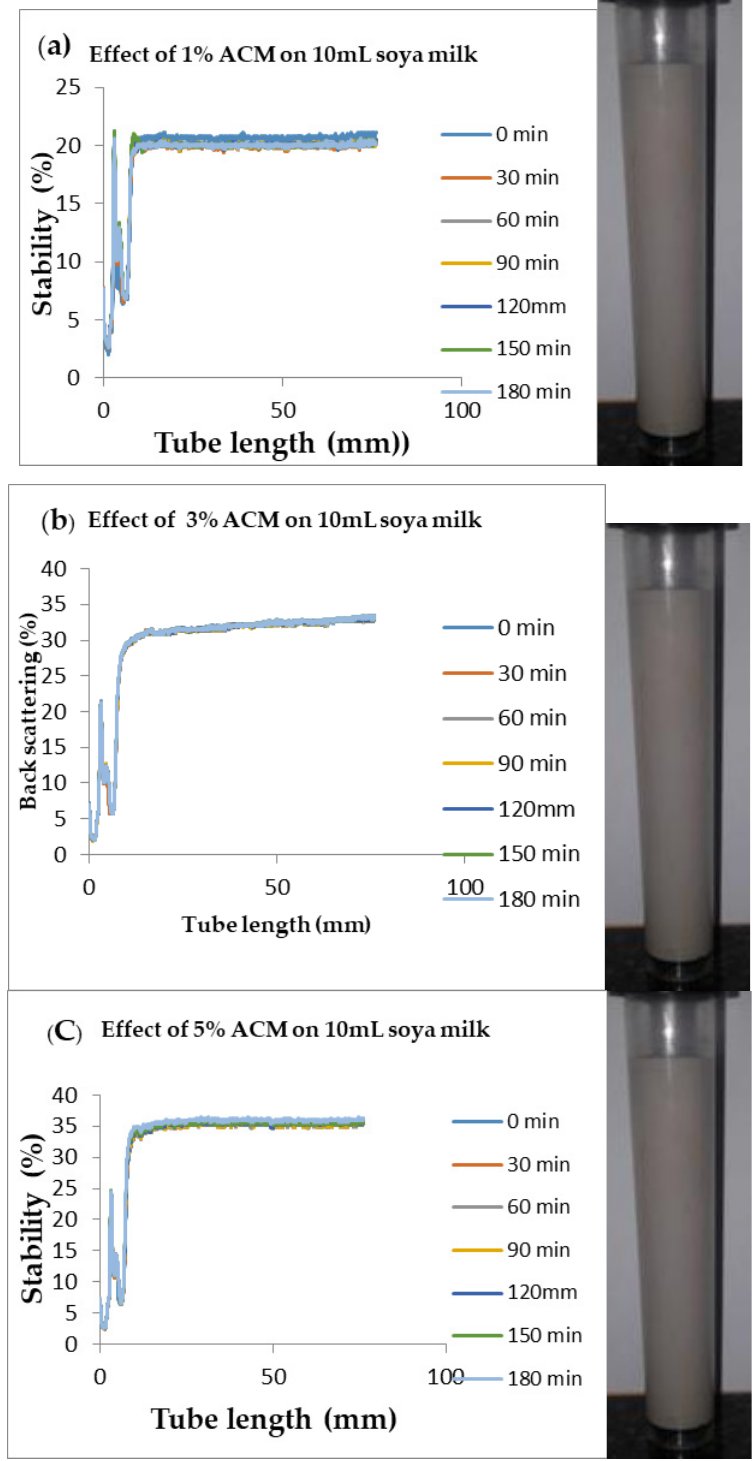
Figure 5. Changes in stability of ACM-stabilized 10 mL ( w / w ) soya milk emulsions ( a ) 1 g w / w ; ( b ) 3 g w / w ; ( c ) 5 g w / w African catfish mucus.